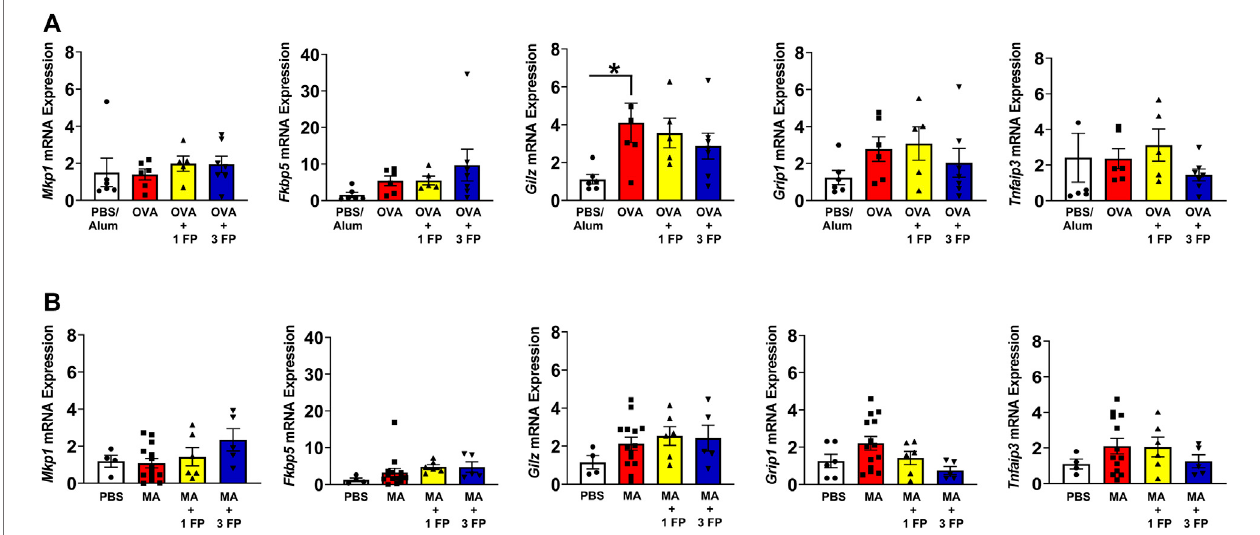
FIGURE 4 | Glucocorticoid receptor (GR) target genes are not altered in OVA- and MA-challenged mice. (A) OVA-challenged mice exhibited higher mRNA expressionexcept Gilz expression. (B) Therewerenosigni fi cantdifferencesinGRtargetgenesinMA-challengedmice.Dataarepresentedas±SEM, n =4 – 14miceper group. p < 0.05. * indicates signi fi cant difference between